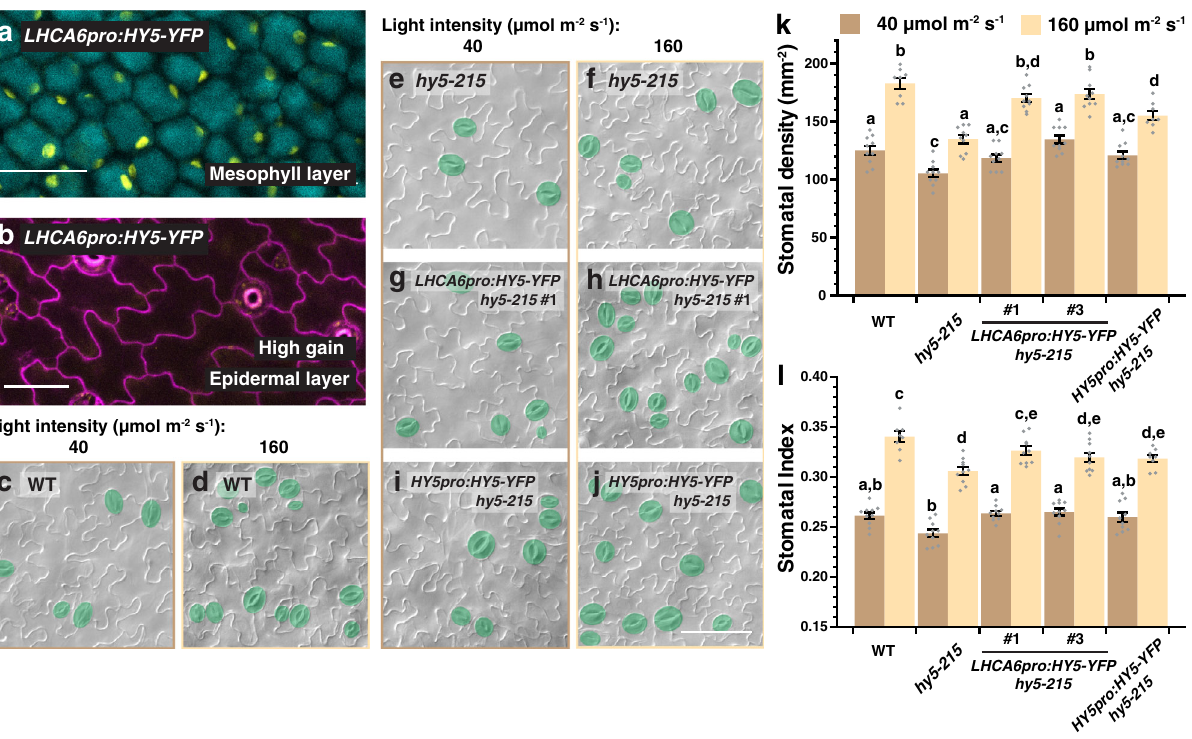
Fig. 4 Mesophyll-derived HY5 is capable of driving stomatal development. a , b Con fi rmation of the mesophyll-speci fi c expression of LHCA6pro:HY5-YFP . Confocal analysis of 3-day-old abaxial cotyledons of LHCA6pro:HY5-YFP in the mesophyll layer ( a ) and the epidermis ( b ). YFP signals (yellow) were detected in ( a ) but not in ( b ). Auto fl uorescence (cyan) of mesophyll cells was captured in ( a ). In ( b ), cell outlines were visualized with propidium iodide (magenta). Scale bar, 50 μ m. Three independent cotyledons were examined with similar results. c – l Genetic complementation of stomatal defects of hy5 by LHCA6pro:HY5-YFP . Arabidopsis seedlings of WT, hy5-215 , two independent lines of LHCA6pro:HY5-YFP in hy5-215 and HY5pro:HY5-YFP in hy5-215 were grown for 10 days at 22 °C under low- and high-light intensities (40 and 160 µ mol m − 2 s − 1 ). Representative images ( c – j ), stomatal densities ( k ), and stomatal indices ( l ) of the abaxial cotyledons are shown. Stomata are pseudo-colored in green ( c – j ). Scale bar, 80 μ m. Values are mean + / − SEM, n = 10 independent cotyledons. Two-way ANOVA with Tukey ’ s multiple comparisons test, P <